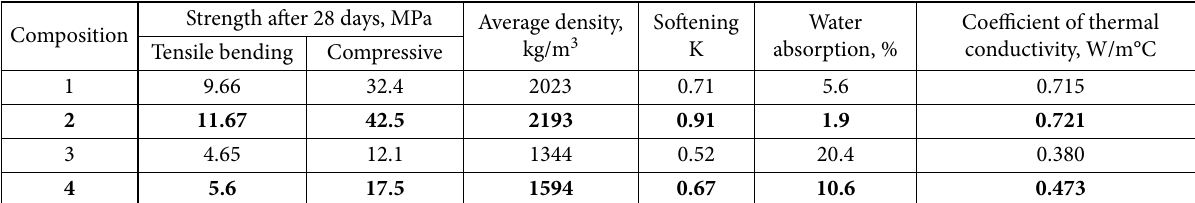
Table 3. The effect of the DC-5 plasticizer on the properties of the fluoroanhydrite composition Strength after 28 days, MPa Average density, Composition